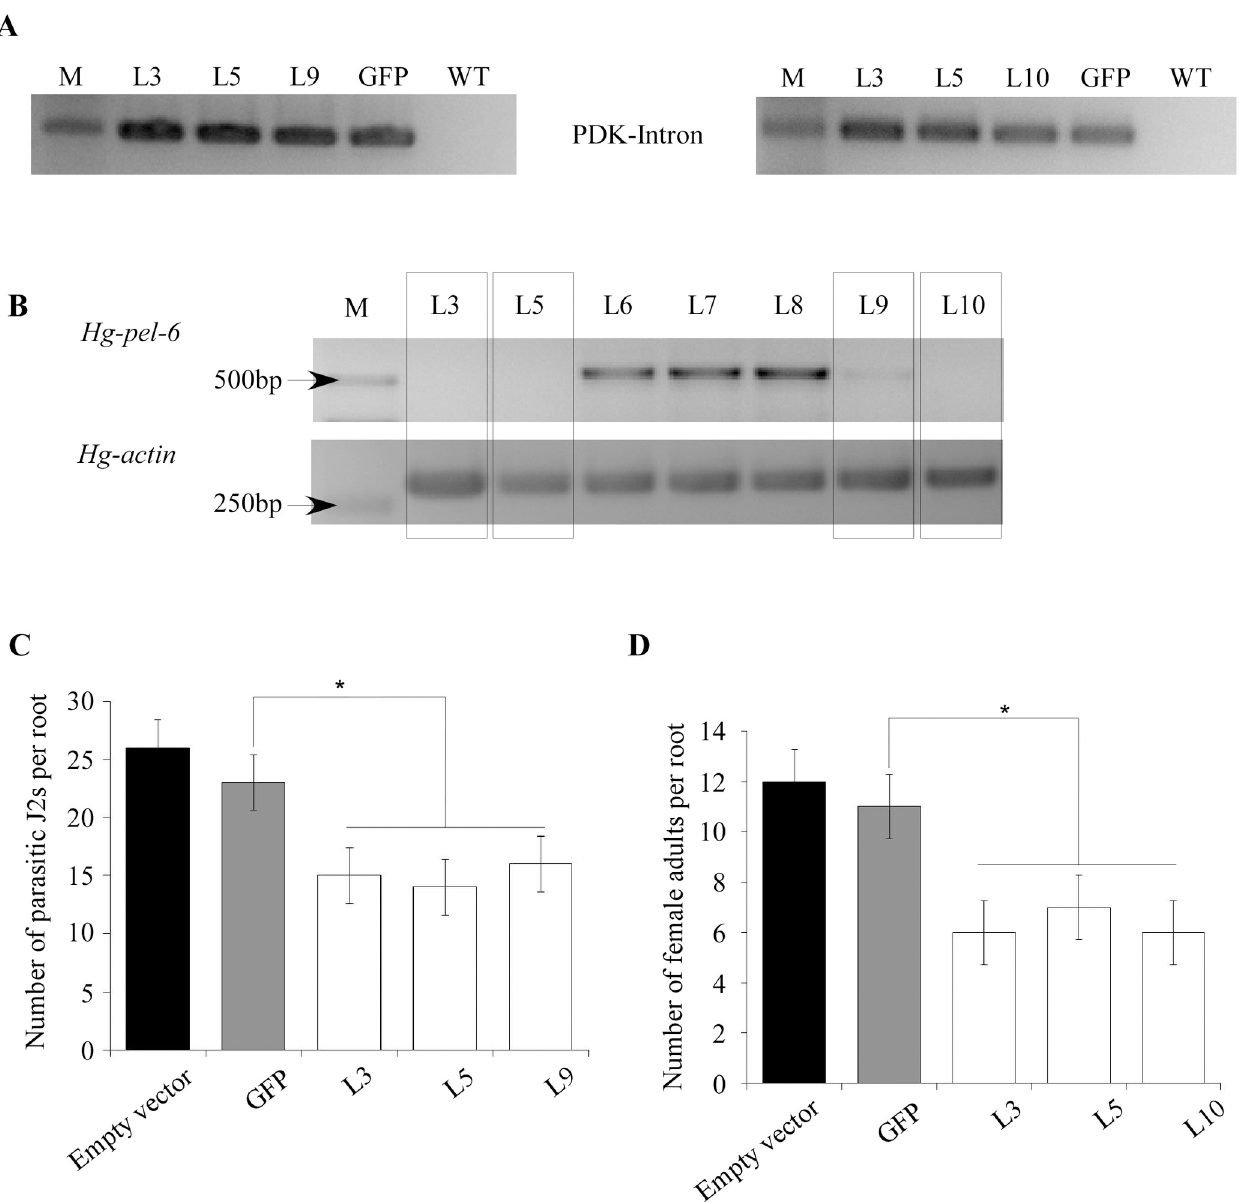
Fig 7. Effect of plant host-derived RNA-interference of Hg-pel-6 on the hairy roots of soybean plants by H . glycines . (A) An RT-PCR of the single- stranded PDK intron of the hairpin dsRNA was used to confirm the expression of the hg-pel6-dsRNA and non-specific control GFP dsRNA (RNAi) in independent hairy roots of soybean lines at 10 d post-germination. (B) A semi-quantitative RT-PCR confirmed the knockdown of Hg-pel-6 expression after an RNAi treatment of H . glycines . (C and D) Number of H . glycines per root system that expressed Hg-pel6 dsRNA at 7dpi and 40dp. The error bars indicate the standard error of the mean; n = 8. The asterisk represents a significant difference (t test, P < 0.05) with respect to the